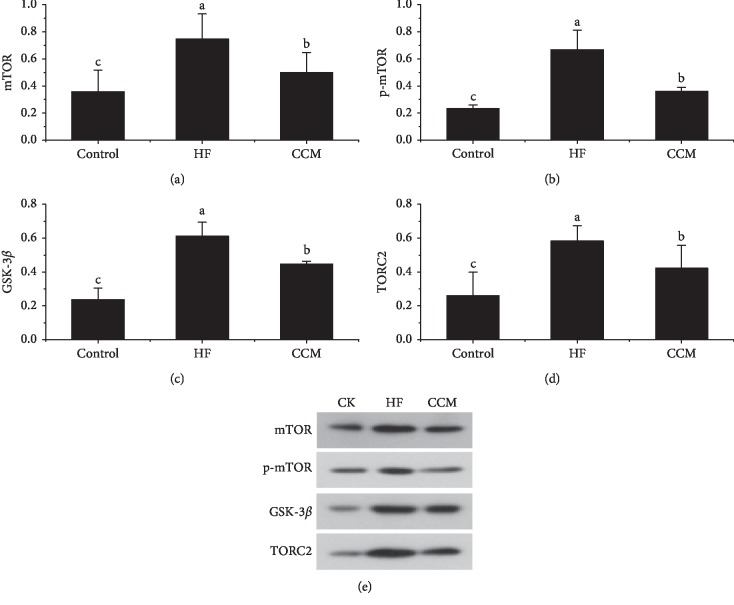
Effects of cardiac contractility modulation (CCM) on mTOR, p-mTOR, GSK-3β, and TORC2 expression in different rabbit myocardial tissues under different treatments. (a) mTOR expression; (b) p-mTOR expression; (c) GSK-3β expression; (d) TORC2 expression; and (e) western blot images of mTOR, p-mTOR, GSK-3β, and TORC2. CK, control group; HF, heart failure. Different lower letters above each boxplot showed the significant differences at p < 0.05.